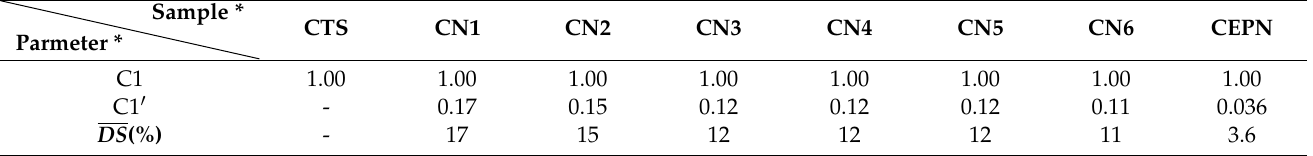
Table 3. Relative areas of 13 C NMR peaks of carbons C1 and C1 (cid:48) of the